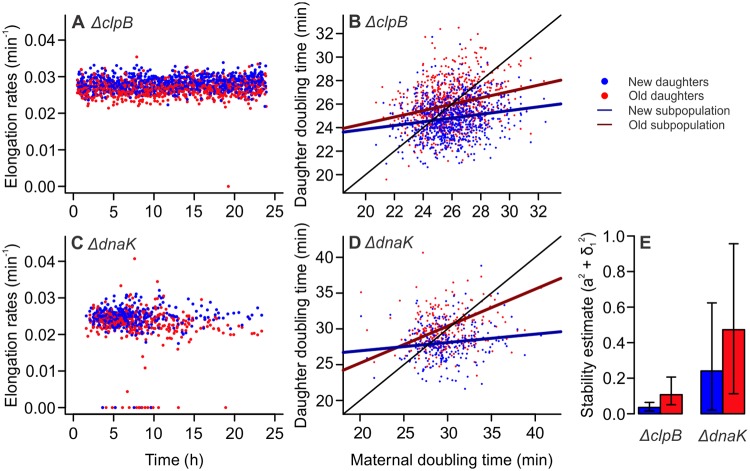
Equilibrium and asymmetry are present in repair mutants lacking ClpB or DnaK chaperones.(A) ΔclpB cells (n = 1,642; 0.027 ± 0.002 [mean ± SD]) exhibited stable elongation rates over time, suggesting these mutants might be in growth equilibrium. A single mortality event was observed. (B) ΔclpB mutants retained asymmetric doubling times (S2 Data). A two-way ANOVA indicated a significant effect of both T0 (F = 82.32, p < 0.001) and age (F = 178.07, p < 0.001) on doubling times, with interaction between factors (F = 5.66, p = 0.017). (C) ΔdnaK mutants (n = 786, 0.0236 ± 0.004) exhibited signs of stability loss, with several mortality events occurring throughout the experiment. (D) Similarly to ΔclpB, ΔdnaK mutants exhibited a separation between new and old subpopulations (S3 Data), with a two-way ANCOVA indicating a significant effect of T0 (F = 12.78, p < 0.001) and age (F = 16.89, p < 0.001) on doubling times, with interaction between factors (F = 5.11, p = 0.024). (E) A stability analysis performed on linear models from (B) and (D) revealed that both strains satisfy the stability requirement a2 + σ12 < 1. Although mortality events were observed for ΔdnaK mutants, the strain remains mostly stable. Our bootstrap analysis (S7 Data) revealed a 1.45% probability of losing equilibrium for old lineages, and complete stability for new lineages (x2 = 129.86, df = 1, p < 0.001). Error bars: 95% CIs. CI, confidence interval; ClpB, chaperone protein ClpB; DnaK, chaperone protein DnaK.